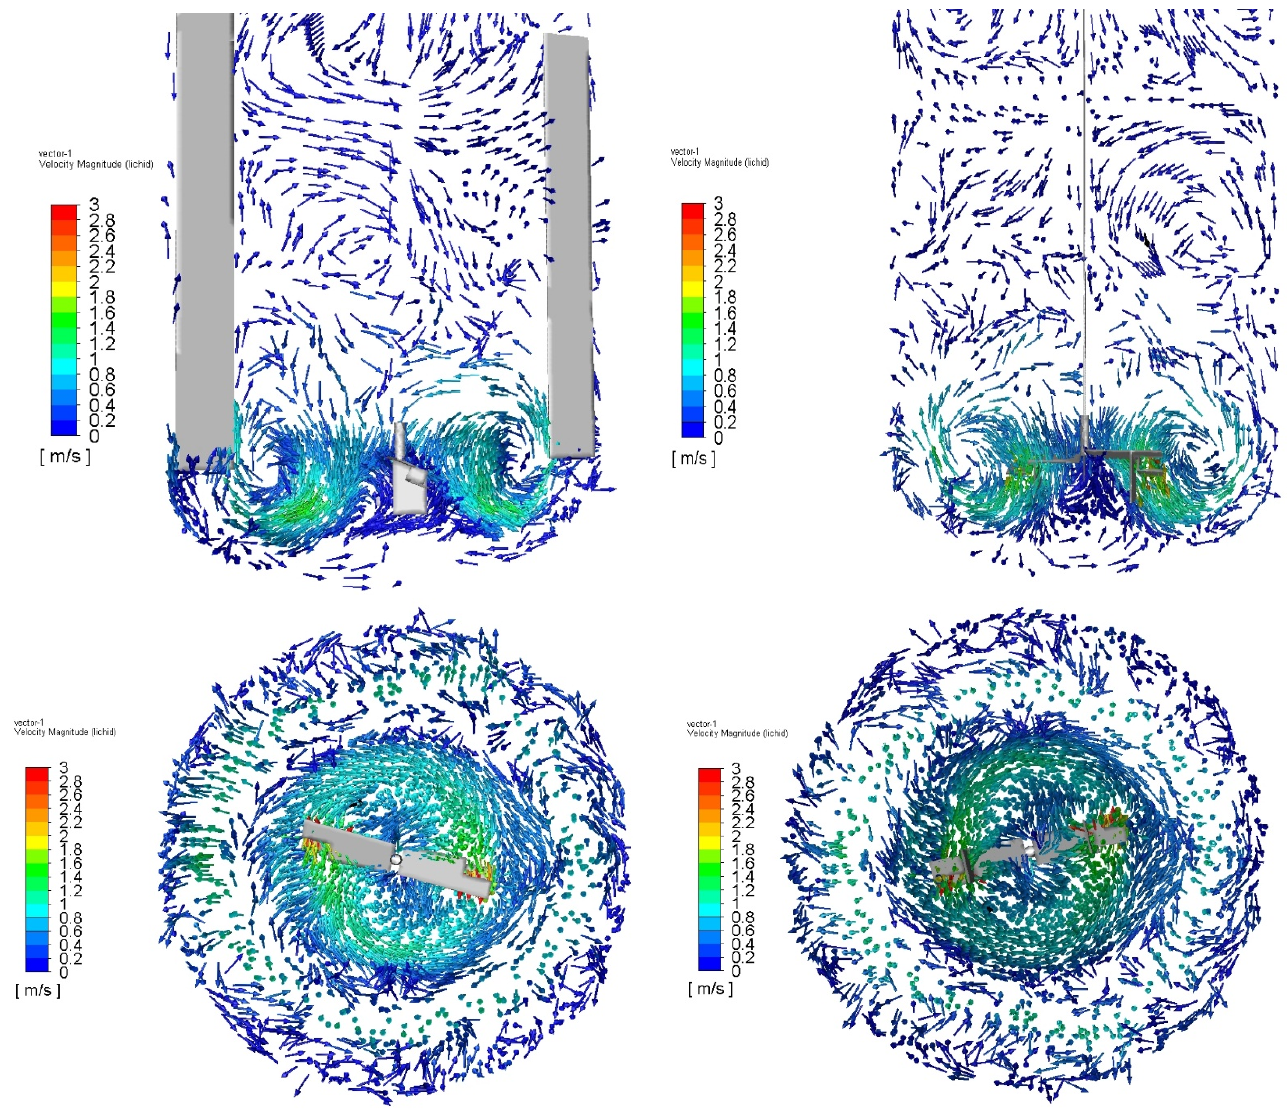
Figure 6. Velocity vector distribution of the liquid phase.